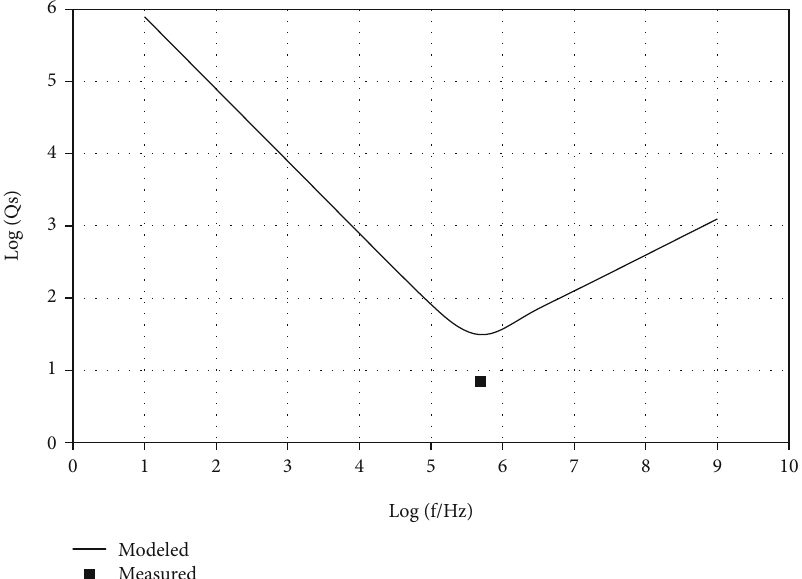
’ Euville limestone under